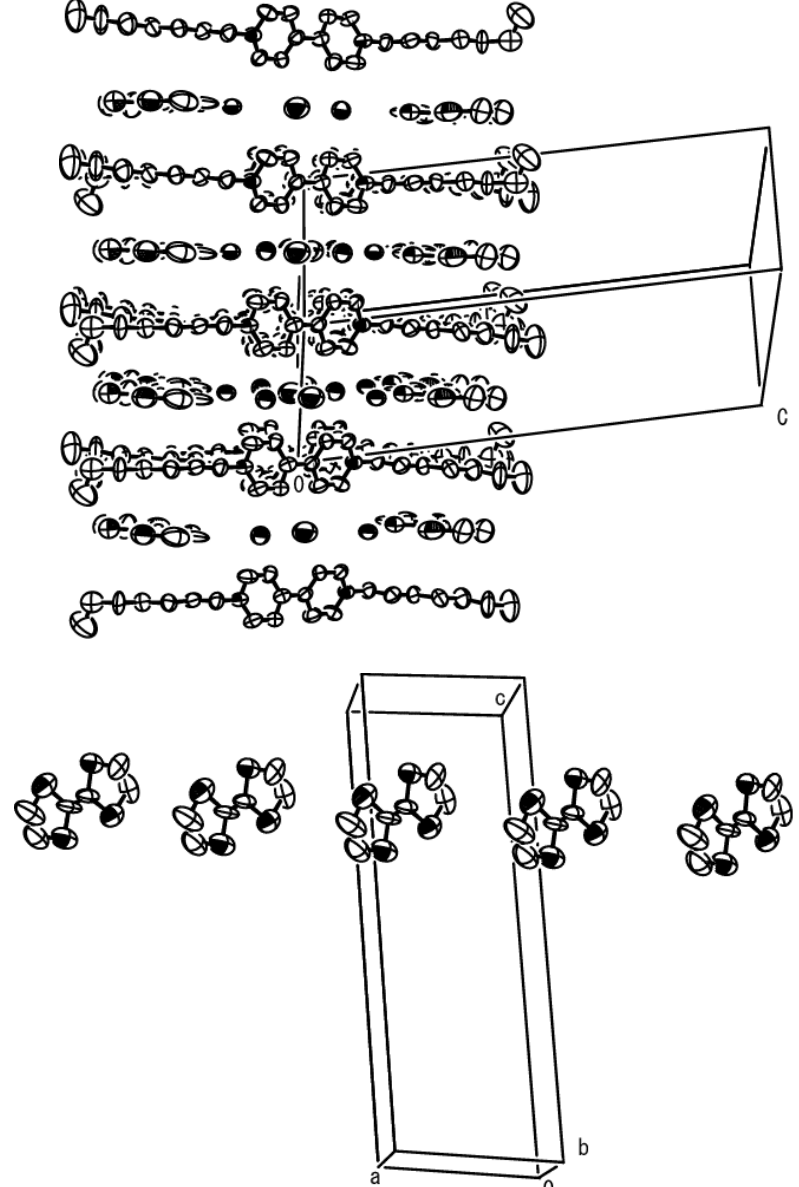
Figure 3. Upper: crystal structure of complex 6 . Lower: 1-D arrangement of TTF